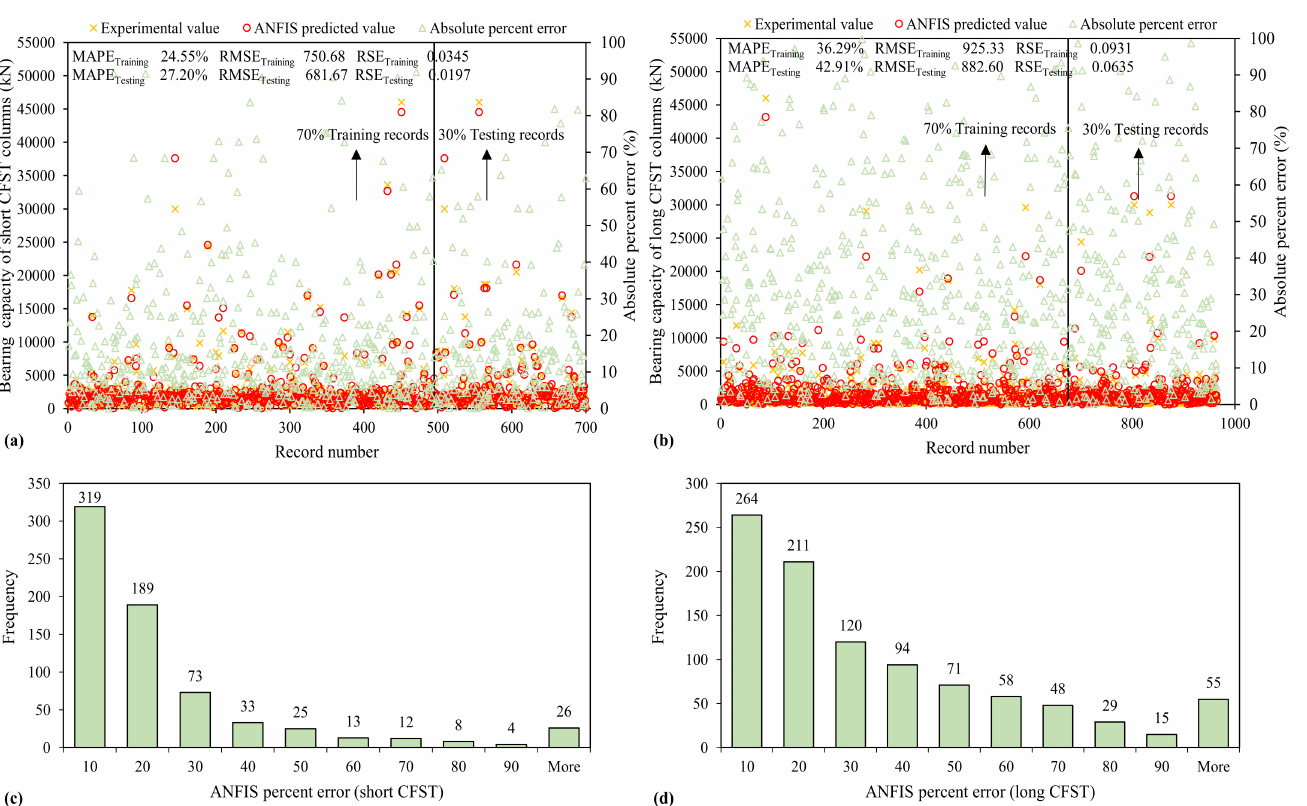
Figure 8. Variation of mean absolute error and error histograms of bearing capacity established using ANFIS algorithm ( a , c ) short CFST ( b , d ) long CFST